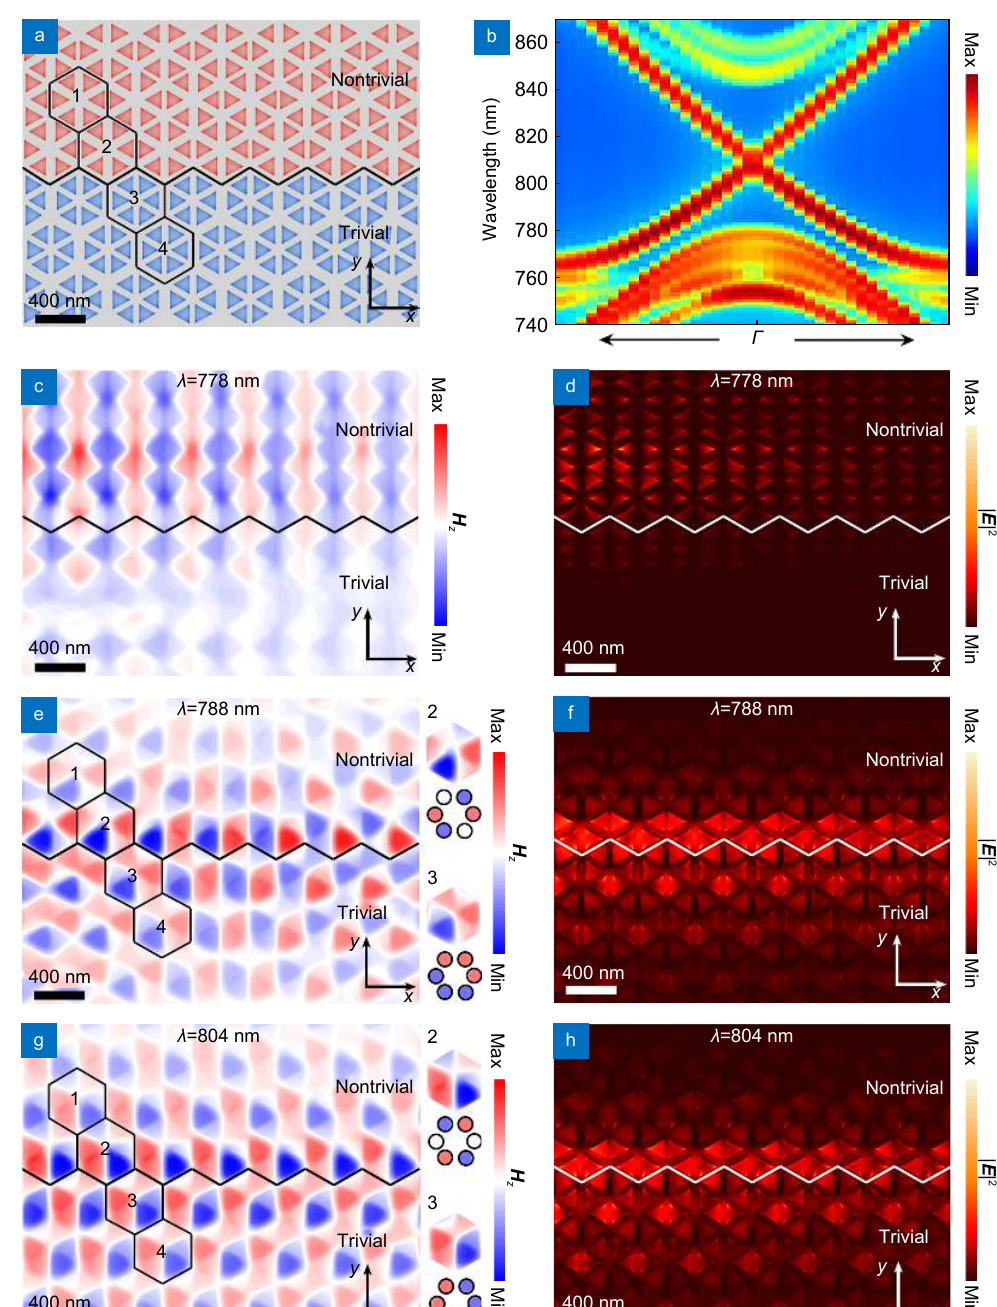
Fig. 4 | Simulation of edge states. ( a ) Schematic of the interface that consists of expanded and shrunken PhCs. The interface of shrunken and expanded PhCs is marked as a zig-zag line. ( b ) Calculated band structure of the interface area. ( c – d ) Simulated expanded bulk state magnetic field ( H z ) and electric intensity (| E | 2 ) distributions at 778 nm ( z = 0). ( e – h ) Simulated Z 2 topological edge state magnetic field ( H z ) and electric in- tensity (| E | 2 ) distributions at 788 nm and 804 nm ( z = 0). The upper (bottom) right-side of (e) and ( g ) shows an enlarged magnetic field of the unit cell 2 (3) and a general quadrupolar (dipolar) mode respectively. Parameters used in Fig. 4 are the same as parameters used in Fig.